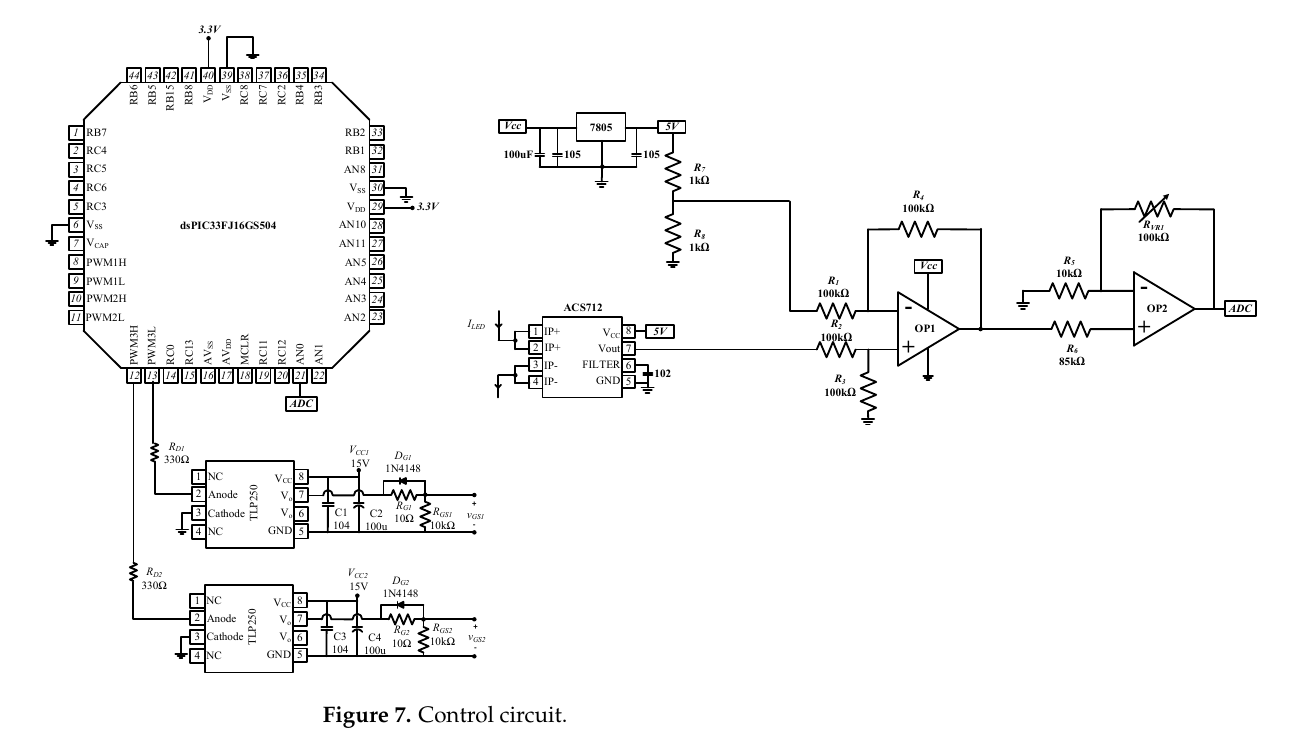
Figure 7. Control circuit.